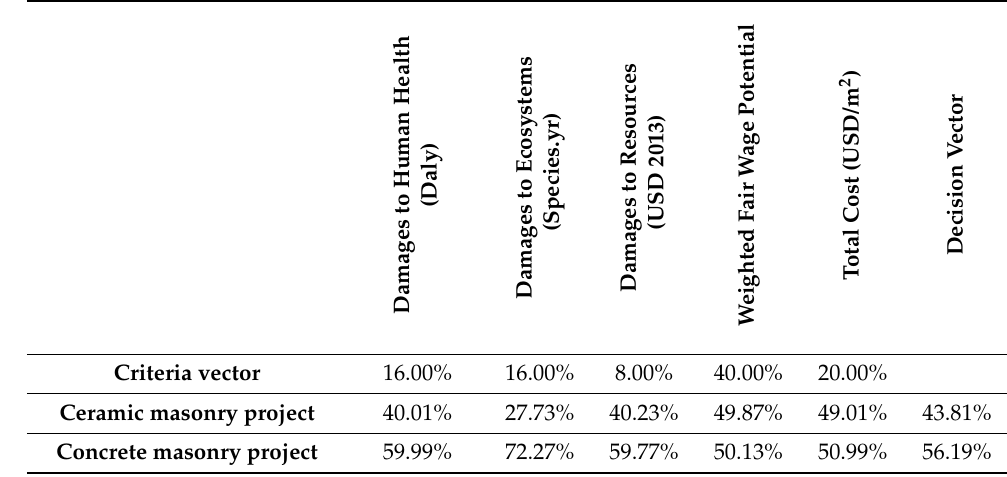
Table 10. Hierarchical perspective: sustainability.